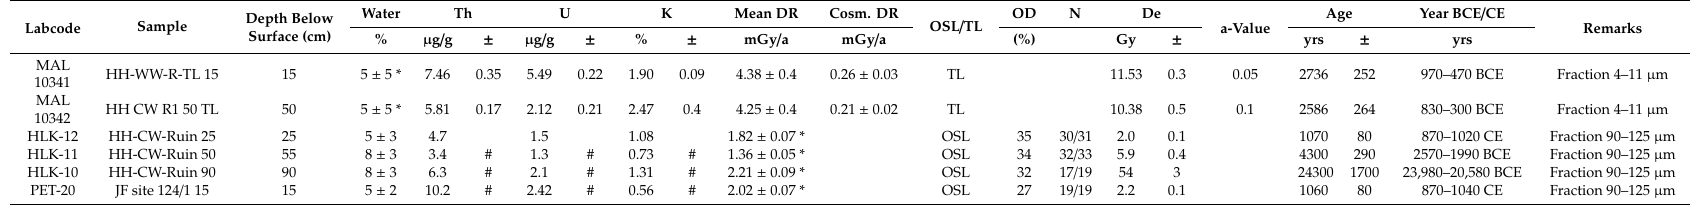
Table A7. Summary of OSL- and TL-dating